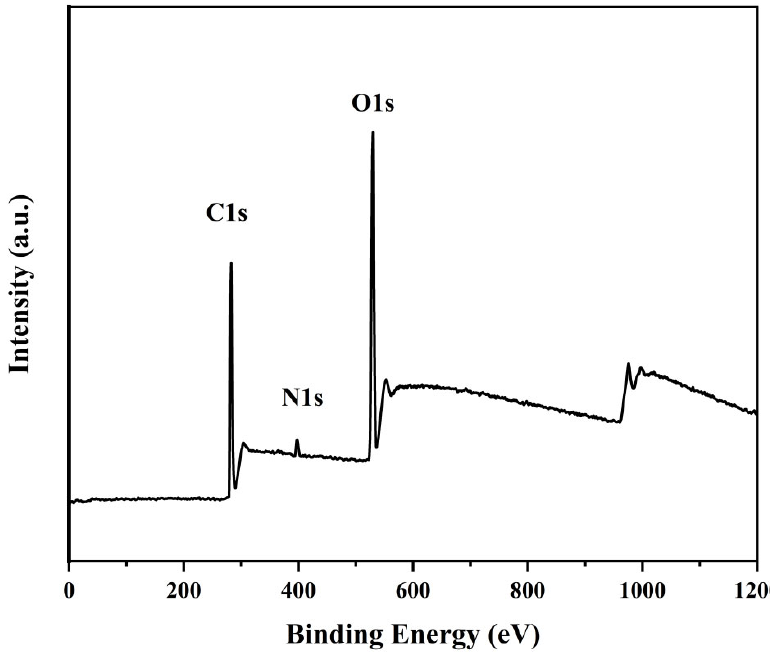
Figure 2. XPS spectra of the hydrogel HMN-4. Molecules 2023 , 28 , 984